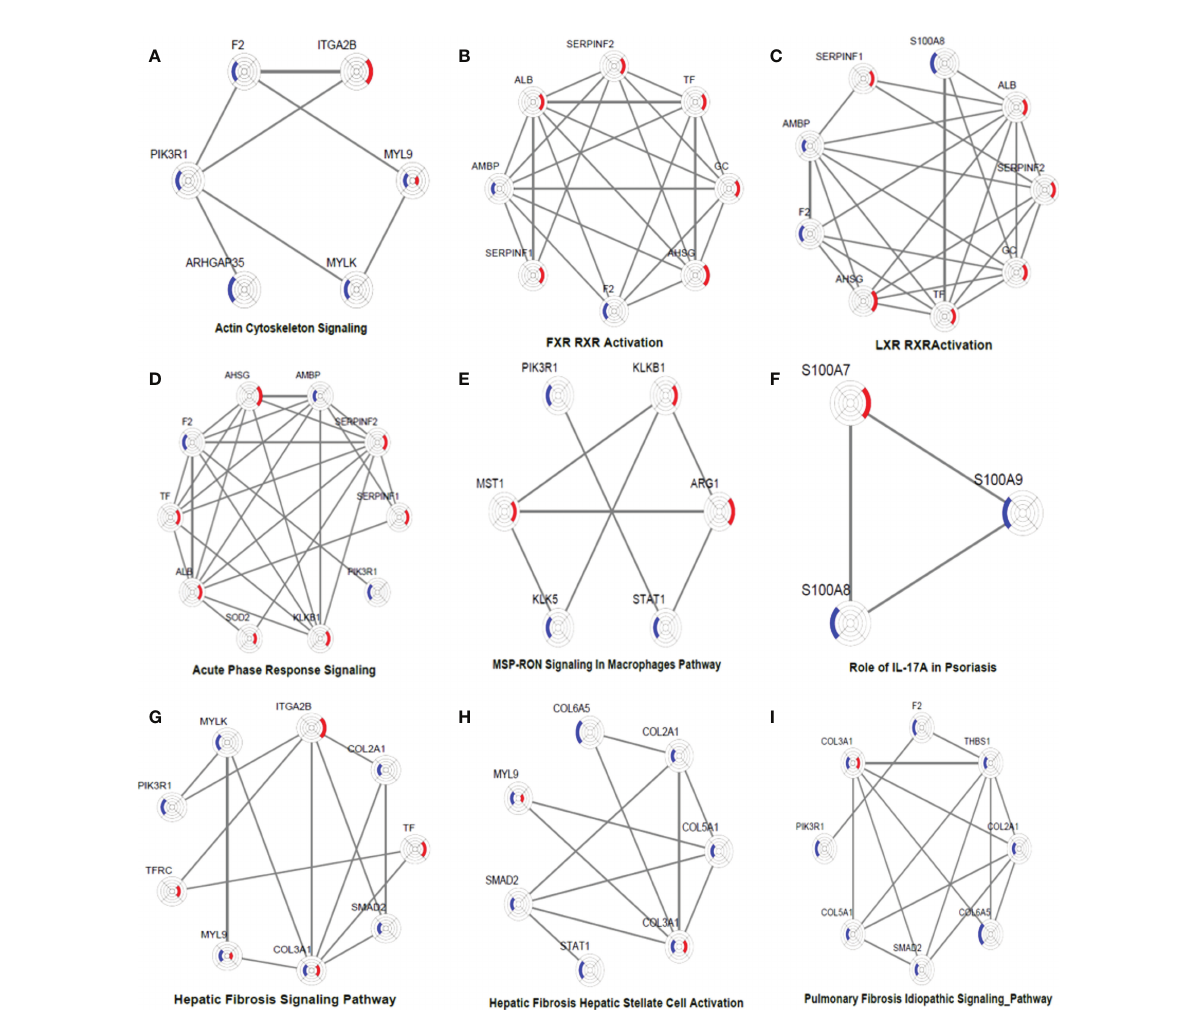
FIGURE 5 DEP networks in nine signi fi cantly enriched pathways. They are actin cytoskeleton signalling (A) , FXR_RXR activation (B) , LXR_RXR activation (C) , acute phase response signalling (D) , MSP-RON signalling in macrophages pathway (E) , Role of IL-17A in psoriasis (F) , hepatic fi brosis signalling Pathway (G) , hepatic fi brosis_ hepatic stellate cell activation (H) , and pulmonary fi brosis idiopathic signalling pathway (I) . Each protein is depicted as a radar chart. Different groups are labelled with different colours. Red area represents the adalimumab group, and blue area represents the secukinumab group. The shadow area covering the circles indicates the FC values for each